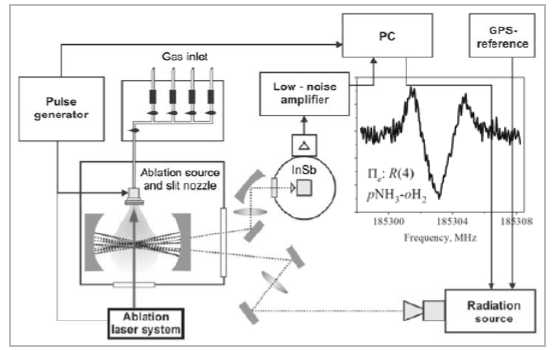
Fig. 3. SuJeSTA spectrometer (150-800 GHz) with multi- pass cell and recorded line of the p NH 3 – o H 2 complex.